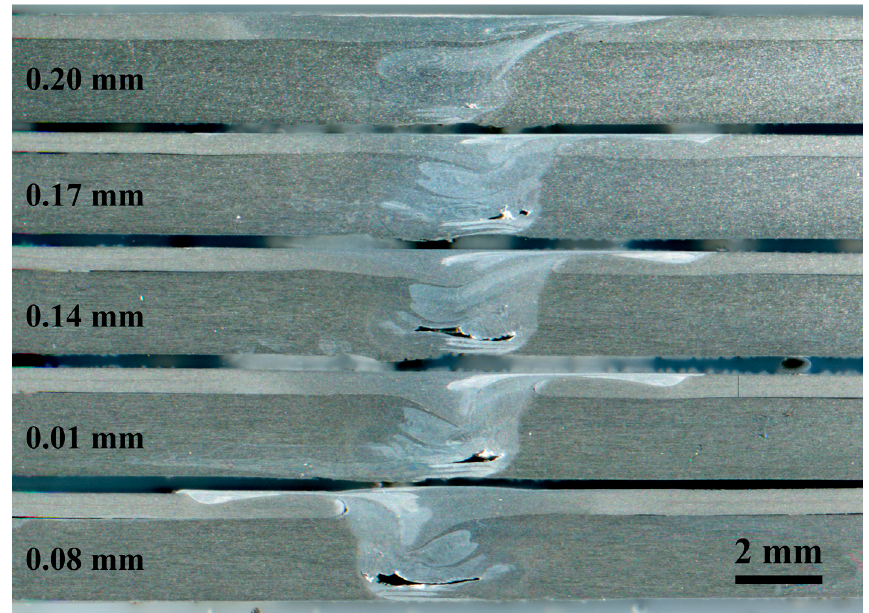
Figure 4. Cross section of the weld seam under different plunge depths.